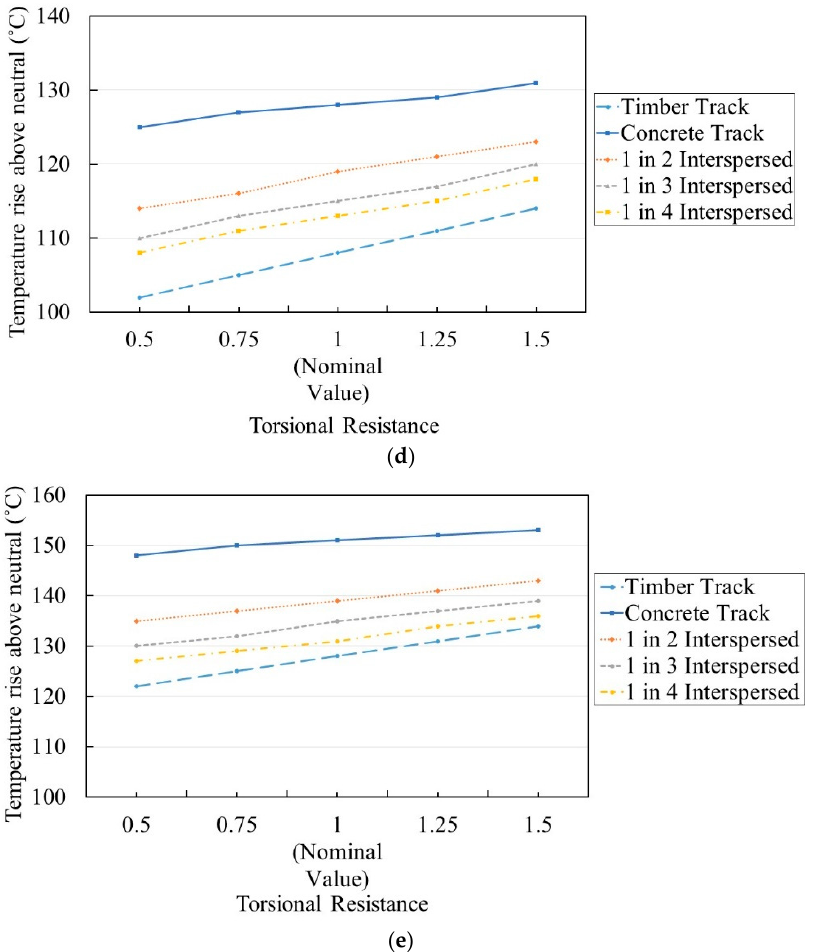
Figure 8. Temperature rise above neutral: ( a ) Lateral stiffness = 120 N/mm (Timber), 200 N/mm (Concrete); ( b ) Lateral stiffness = 360 N/mm (Timber), 600 N/mm (Concrete); ( c ) Lateral stiffness = 600 N/mm (Timber), 1000 N/mm (Concrete); ( d ) Lateral stiffness = 840 N/mm (Timber), 1400 N/mm (Concrete); ( e ) Lateral stiffness = 1200 N/mm (Timber), 2000 N/mm (Concrete).